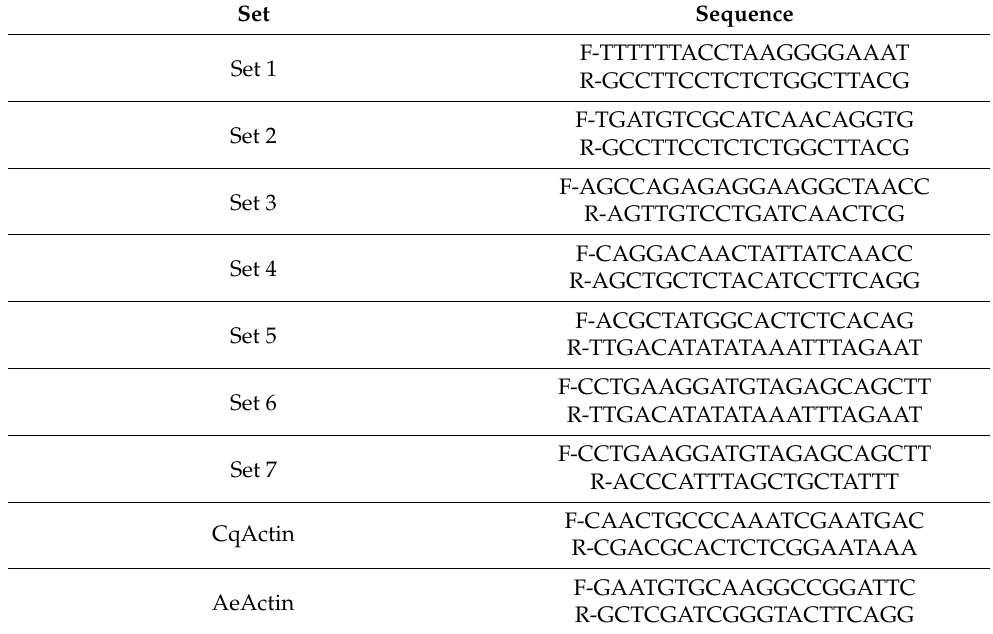
Table 3. PCR Primers for LACV S segment (OP962746) vDNA Detection.